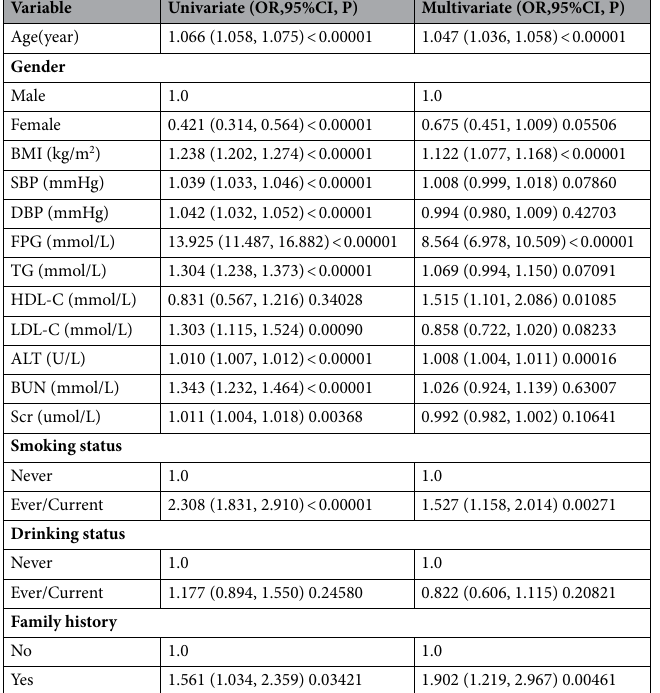
114.42 ± 14.89 mmHg, and 5.15 ± 0.41 mmol/L, respectively. The median TG was 0.75 (0.50–1.12) mmol/L. (Table S4).The AUC of the external validation was 0.849 (Fig. 7A). At the best threshold, the specificity and